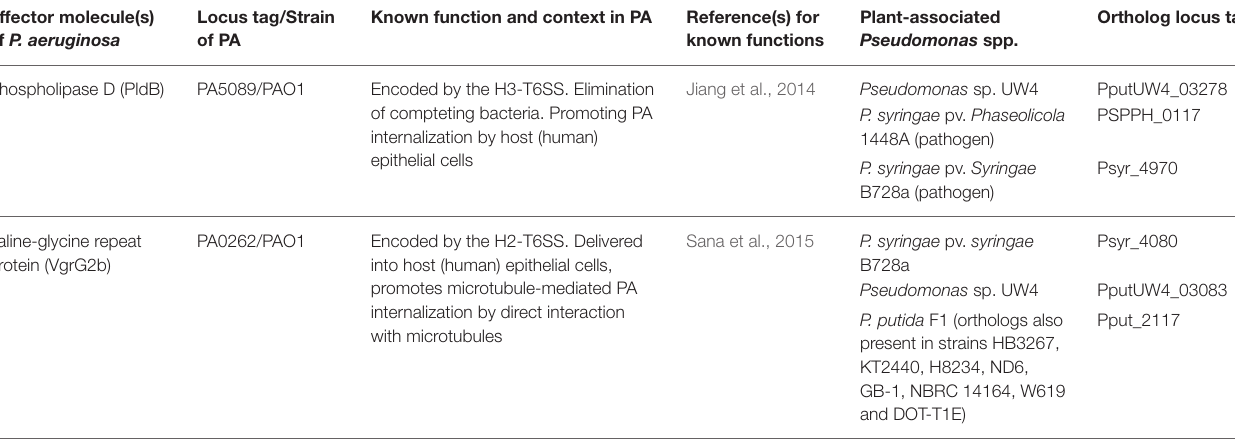
TABLE 1 | A representative list of putative effectors potentially targeting plant cells and encoded by T6SS in plant-associated Pseudomonas spp. Effector molecule(s) Locus tag/Strain of P. aeruginosa of PA